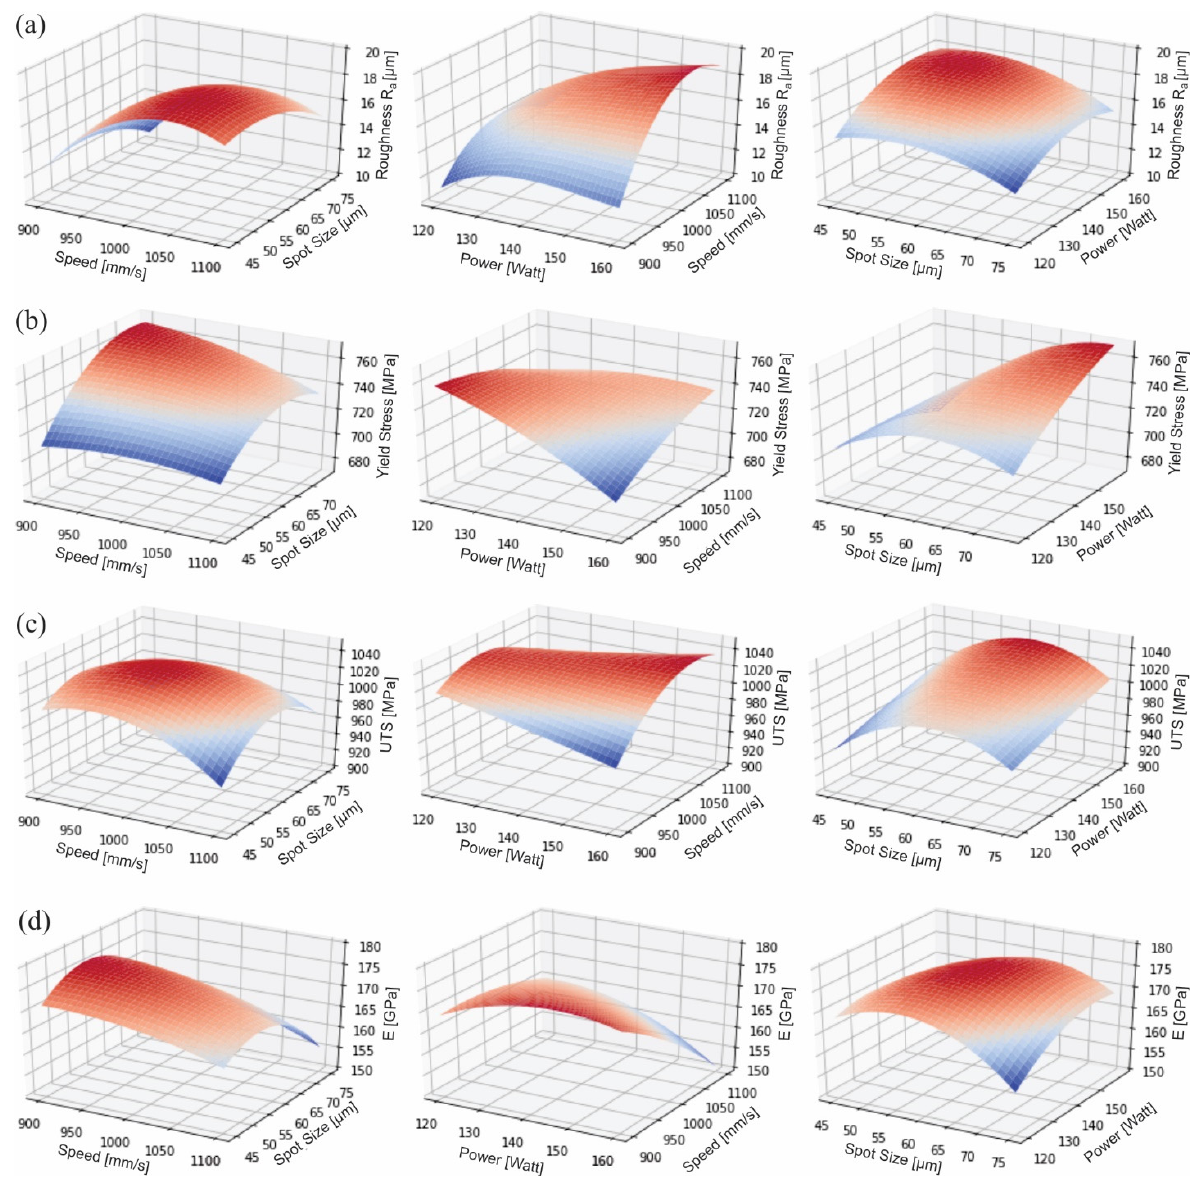
Figure 8. Response surface plots for the regression model of ( a ) Roughness, ( b ) Yield Strength, ( c ) Ultimate Tensile Strength and ( d ) Elastic Modulus dependent on the examined parameters.